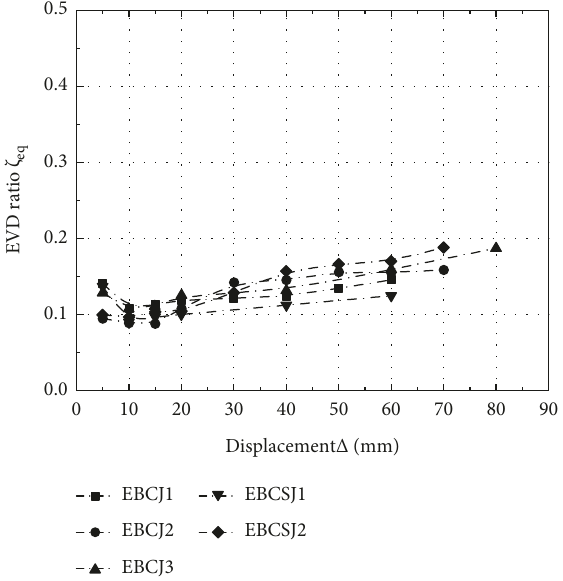
Figure 11: Viscous damping